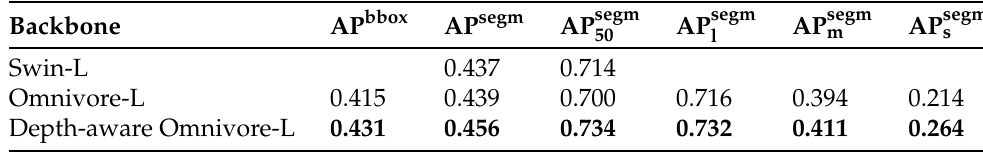
Table 3. Instance segmentation results on the Cityscapes validation set. The depth-aware Omnivore-L variant clearly improves the non-depth-aware variant in all metrics. The metrics of the Swin-L backbone were obtained using the original implementation [15]. AP segm and AP segm metrics; the rest are COCO metrics. The respective best value for each metric is highlighted in bold.